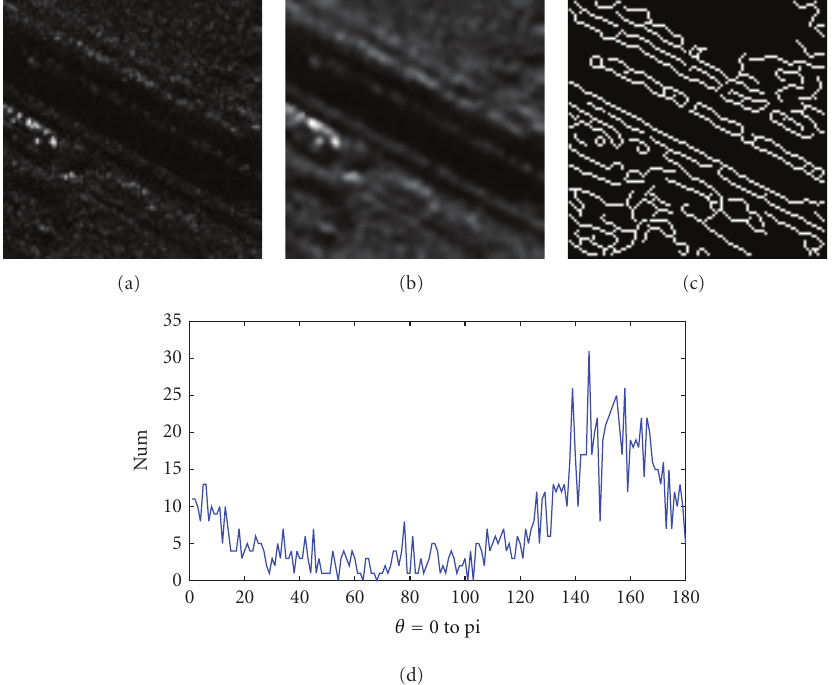
Figure 5: Orientation estimation 1. (a) Cropped SAR image. (b) Frost filter. (c) Canny edge detection. (d) Edge orientation histogram.